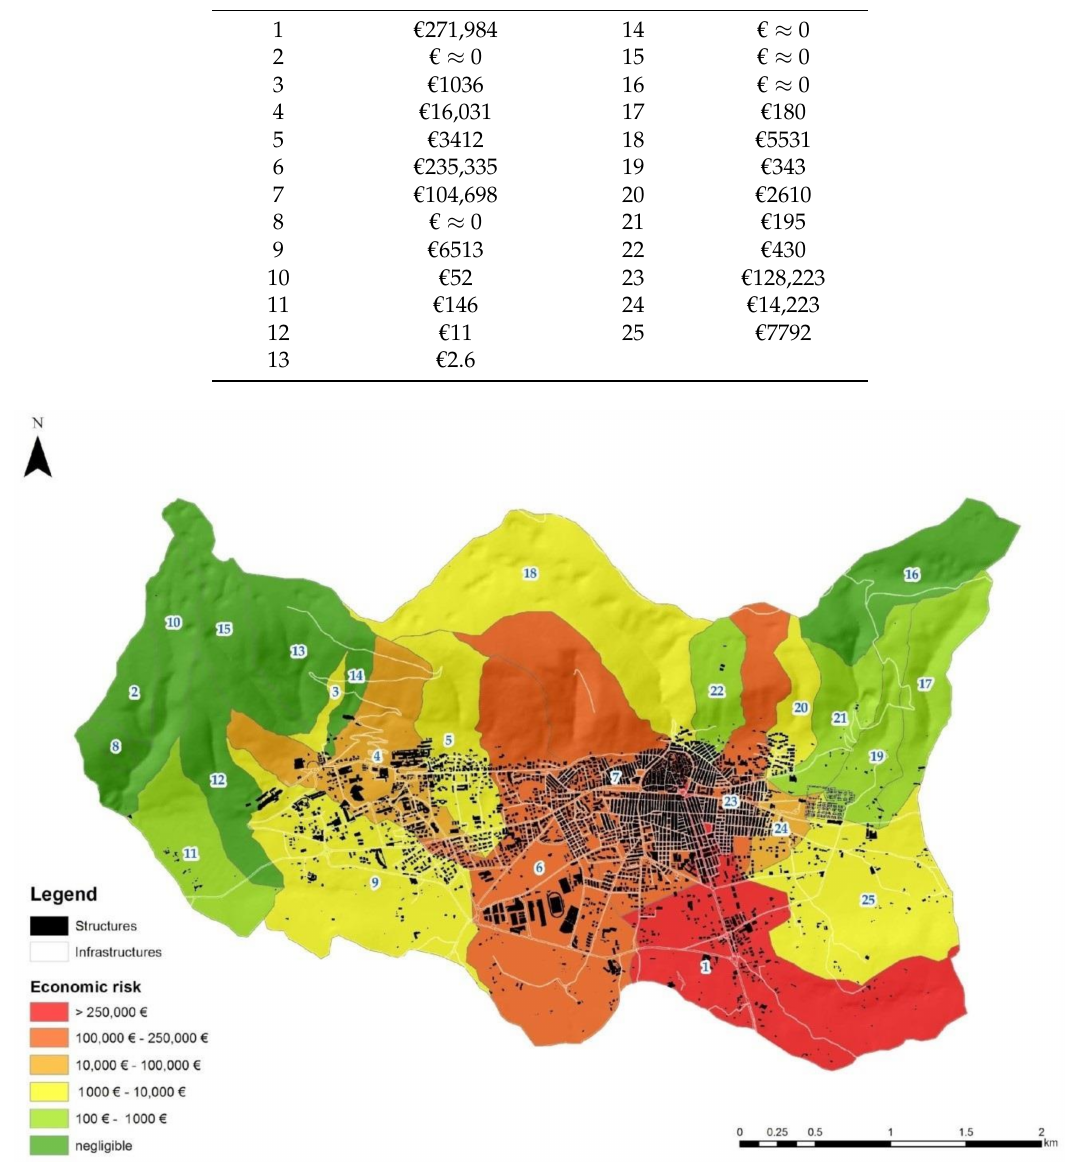
Figure 9. Ranking map of the 25 sub-basins according to economic flooding